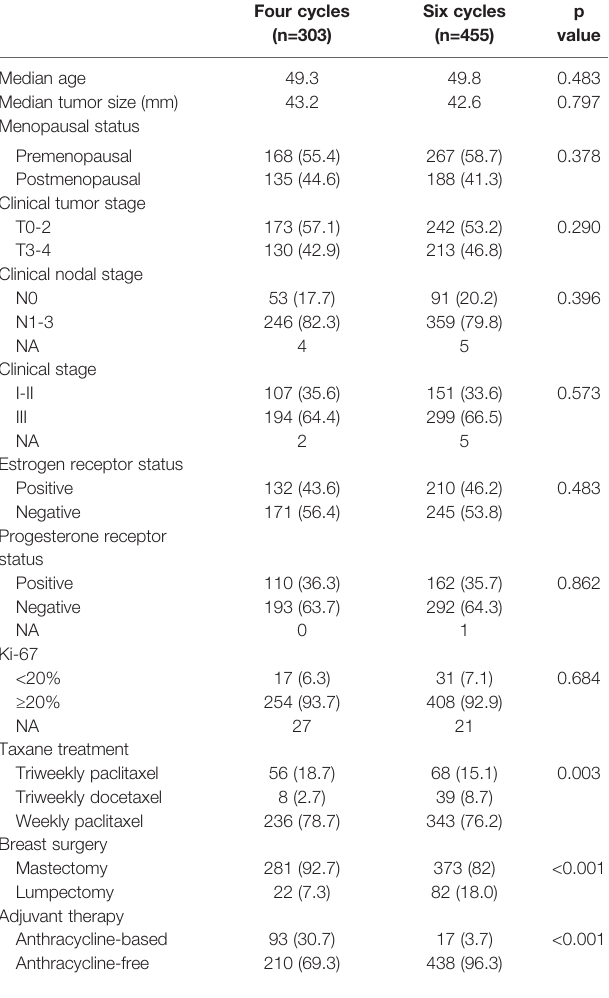
TABLE 1 | Clinicopathologic characteristics of study